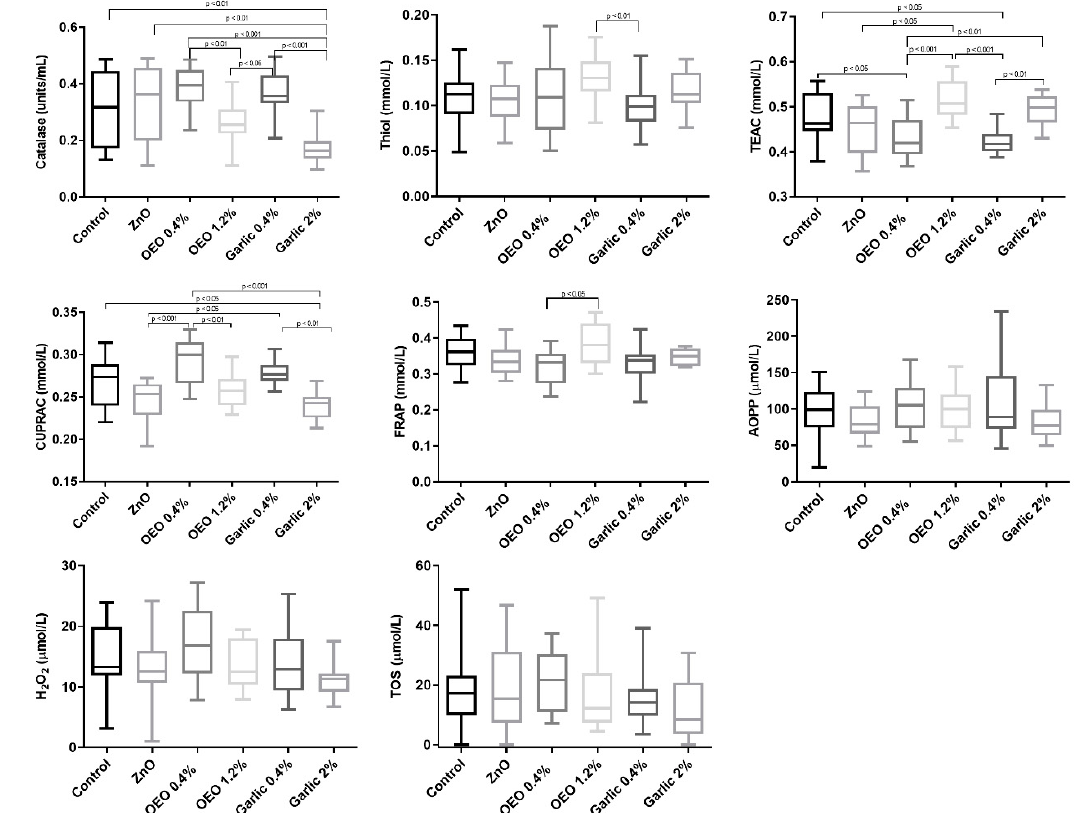
Figure 1. Results for serum catalase, thiol, Trolox equivalent antioxidant capacity (TEAC), cupric reducing antioxidant capacity (CUPRAC), ferric reducing ability of plasma (FRAP), advanced oxidation protein products (AOPP), hydrogen peroxide (H 2 O 2 ), and total oxidant status (TOS) in piglets supplemented with ZnO, micro capsuled OEO at a concentration of 0.4% in the basal diet, micro capsuled OEO at a concentration of 1.2% in the basal diet, garlic powder at a concentration of 0.4% in the basal diet, and garlic powder at a concentration of 2% in the basal diet. The plots show median (line within box), 25th and 75th percentiles (box), and minimum and maximum values (whiskers).